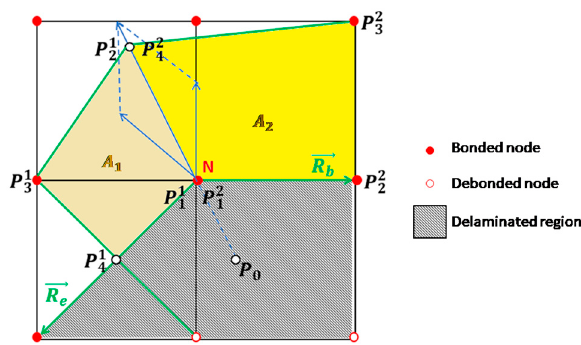
Figure 7. XB points and virtually closed area definition for the node N.